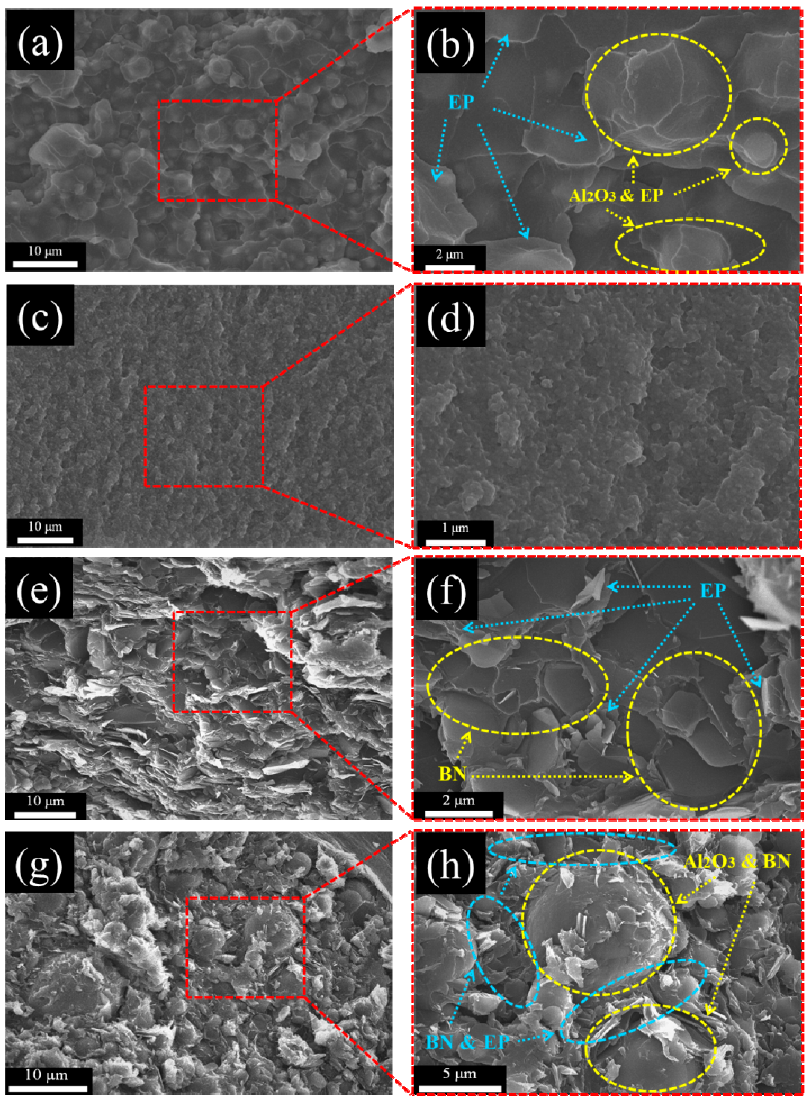
Figure 10. SEM images of EP composites with ( a,b ) m-Al 2 O 3 80 wt%; ( c , d ) n-Al 2 O 3 60 wt%; ( e , f ) BN 40 wt% and ( g , h ) m-Al 2 O 3 -BN 80